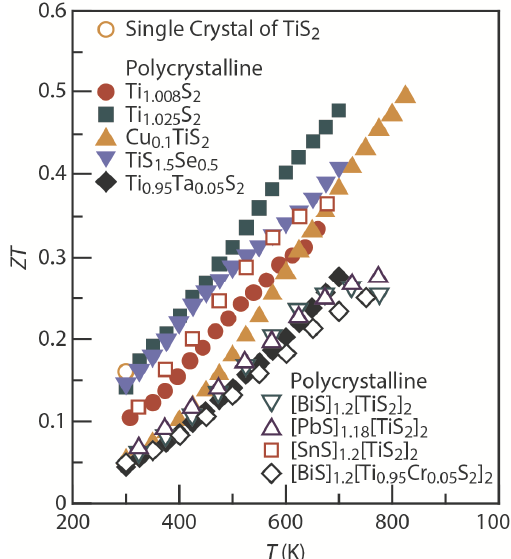
Figure 5. Current state-of-the-art TiS 2 -based layered sulfides. Temperature dependence of